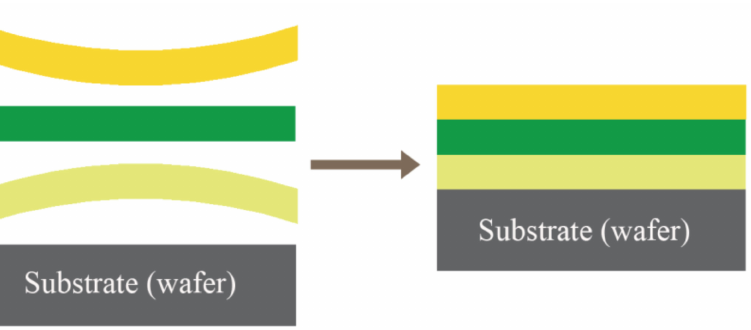
Figure 8. Schematic of the stress-compensated effect.